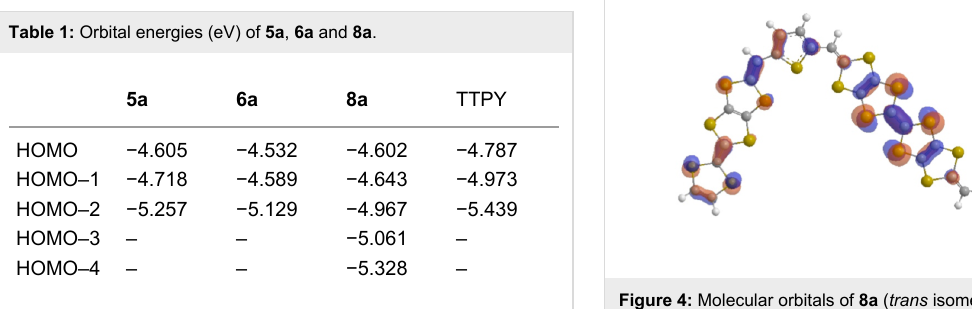
than that of TTPY (0.186 eV). In particular, the orbital energies of the HOMO and HOMO–1 of 8a ( − 4.602 and − 4.643 eV, res- pectively) were close to each other, suggesting that the first four-electron oxidation of 8a might occur in a narrow potential range. The HOMO–2 of 5a and 6Aa ( − 5.257 and − 5.129 eV, respectively) and HOMO–4 of 8a ( − 5.328 eV) were slightly higher than the orbital energy of the HOMO–2 of TTPY ( − 5.439 eV). These results suggest that the electrons at the HOMO–2 of 5a and 6a and HOMO–4 of 8a might be removed more easily than those at the HOMO–2 of TTPY.